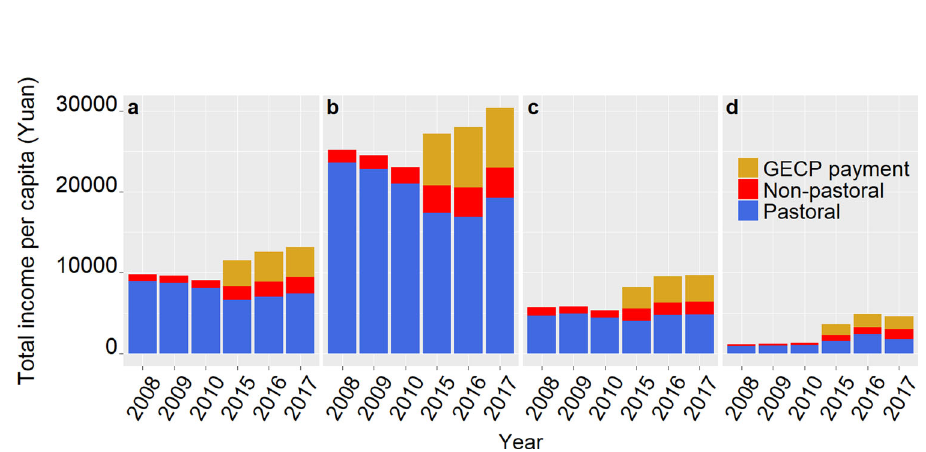
fodder. Village-level controls include an indicator of whether a village has local grassroots measures in place to limit grazing intensity, an indicator of whether a village has a formal government-run monitoringsystem,and climatevariables (cumulativerainfalland mean temperaturefromMay toOctober in eachyear). Township-level controlsincludefarm-gate livestockprices,hayprices, wagesfor non-pastoral employment, and grassland rental prices. Standard errors are clustered at the village-by-year level. A two-sided t test is performed for each coef fi cient. The exact p -values are in parentheses. * p < 0.10, *** p < 0.01.